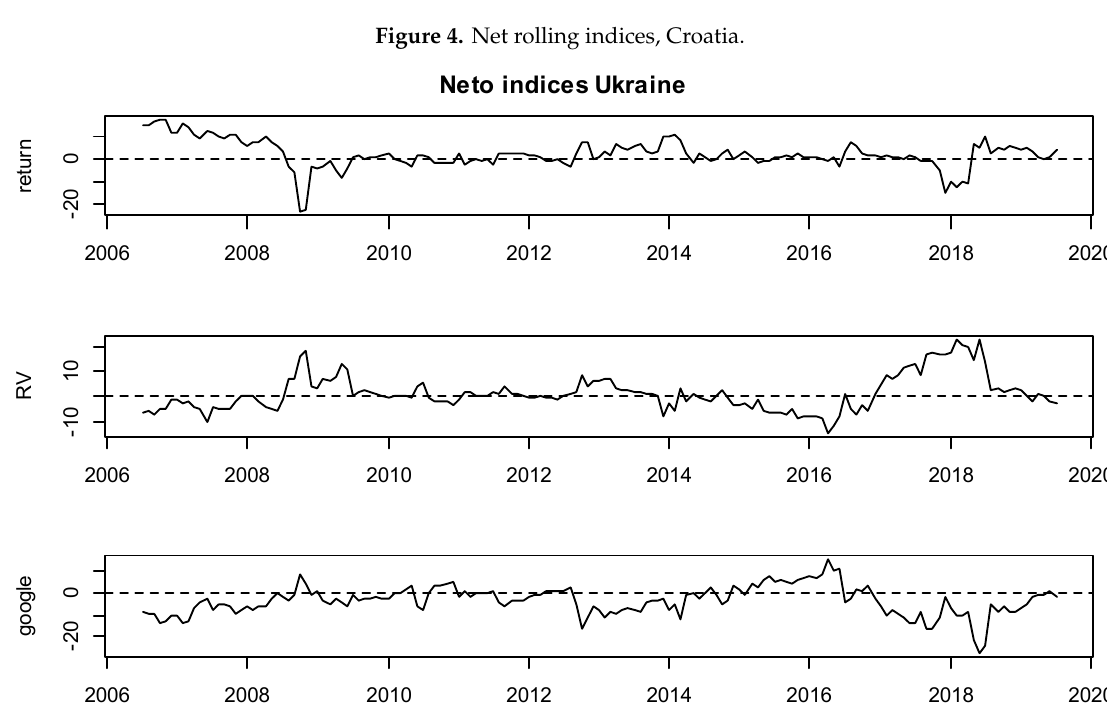
Figure 5. Net rolling indices, Ukraine.